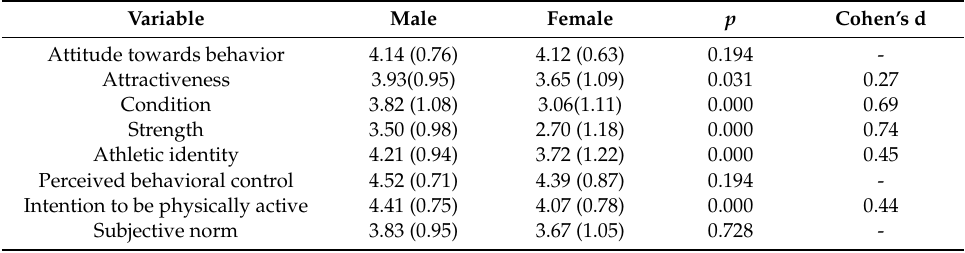
Table 3. Means comparisons of variables related to physical activity intentions after finishing secondary school female vs. male sample.